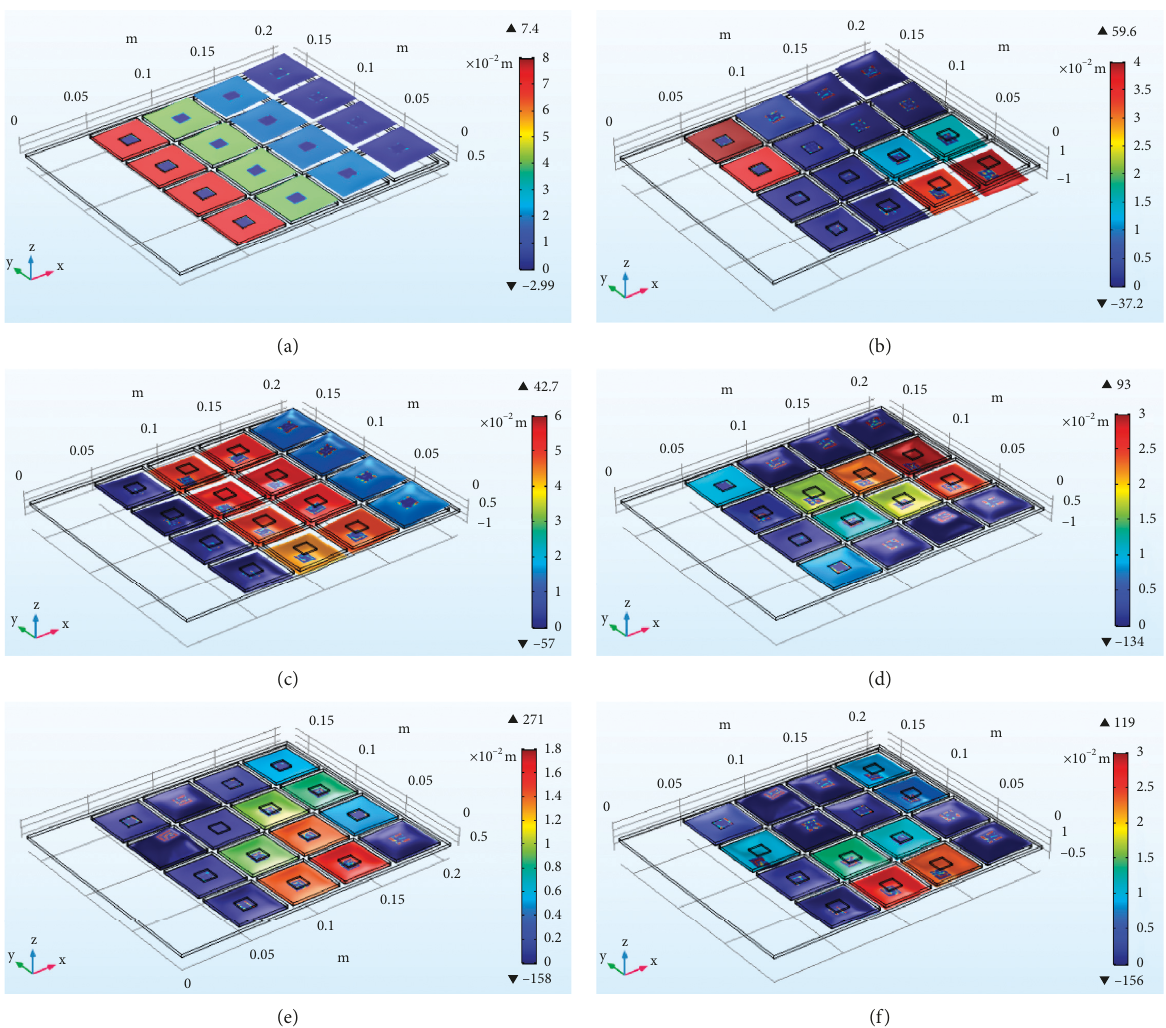
Figure 18: Piezoelectric voltages under the first six modes. (a) First. (b) Second. (c) Third. (d) Fourth. (e) Fifth. (f) Sixth.